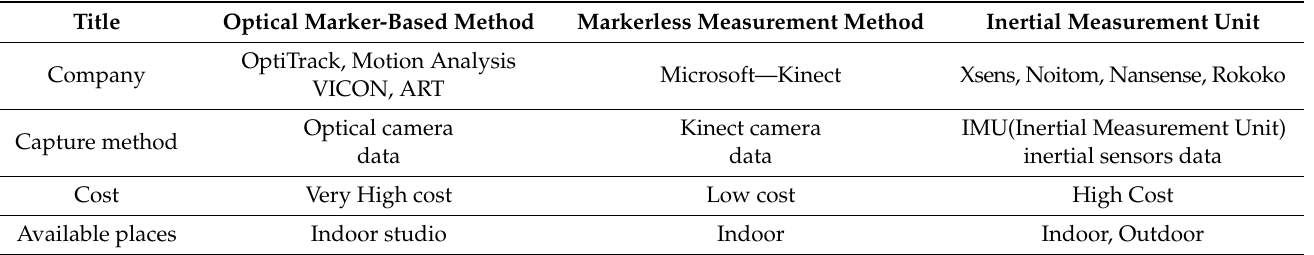
Table 2. Three types of motion